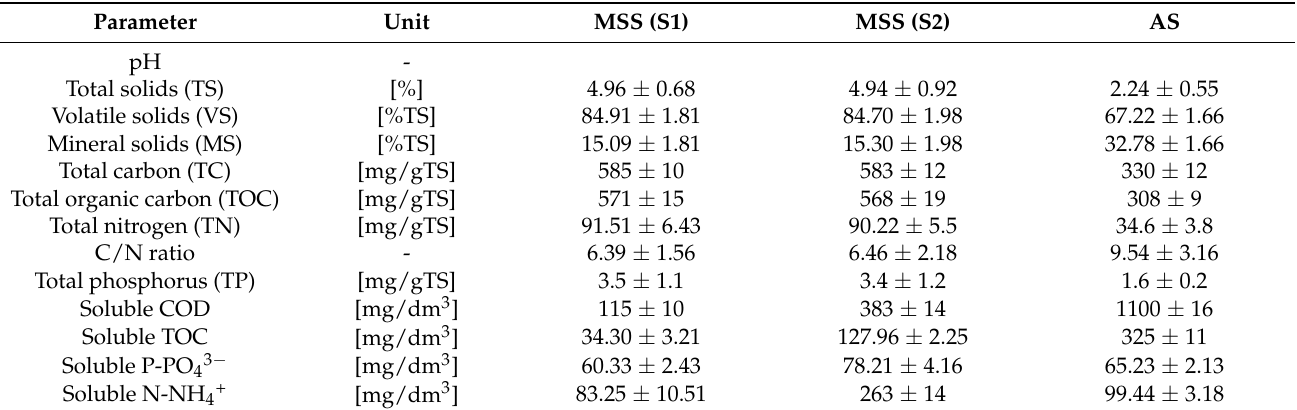
Table 1. Characteristics of the sludge types used in the